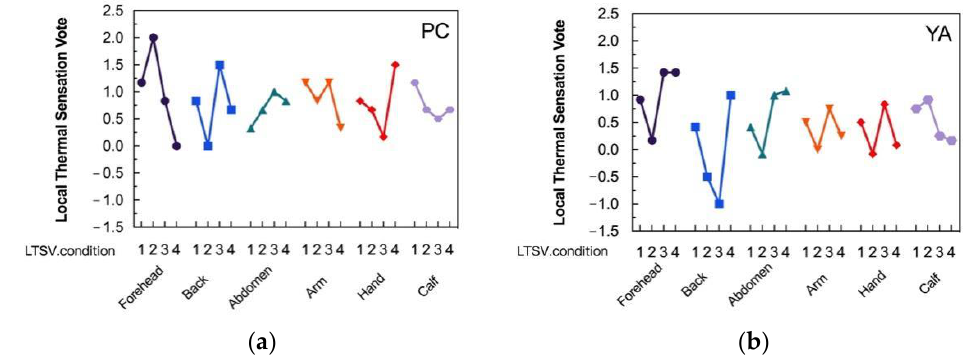
Figure 7. Local thermal sensation vote of two types of participants: ( a ) Preschool children; ( b ) Young adults.